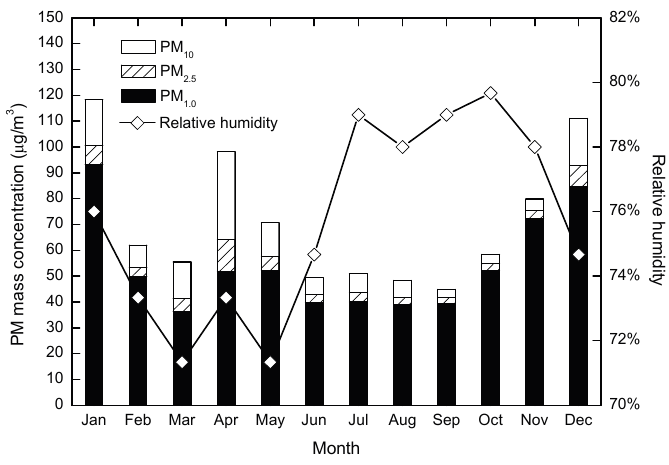
Figure 8. Variations in monthly mass concentrations of PM 10 , PM 2.5 and PM 1.0 related to RH.